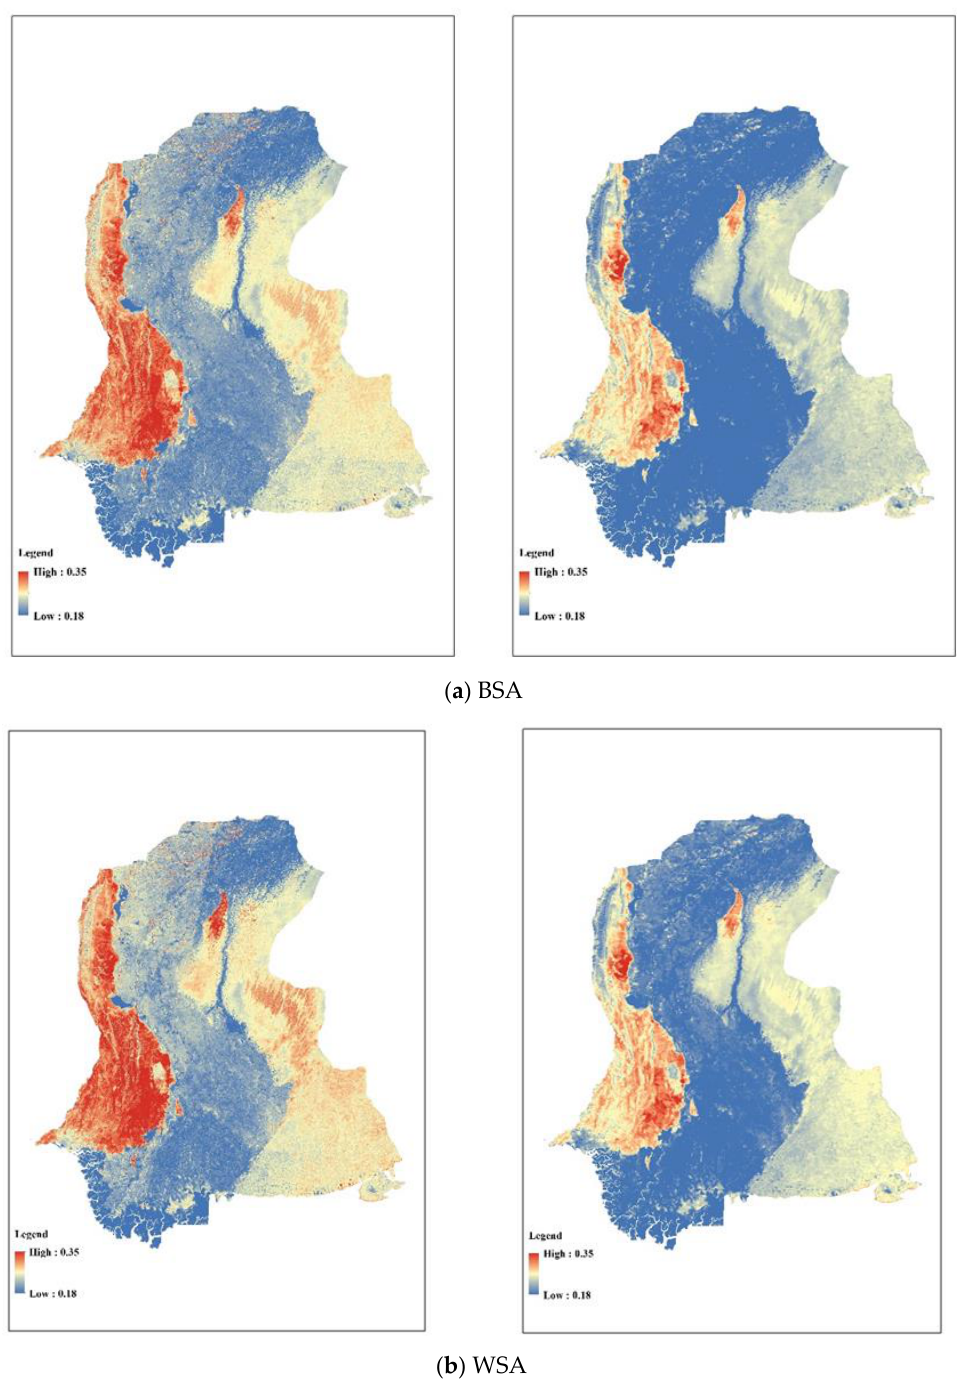
Figure 12. Comparison of the ( a ) black-sky albedo and ( b ) white-sky albedo of the GF-1 (left) and GLASS (right) in Sindh.